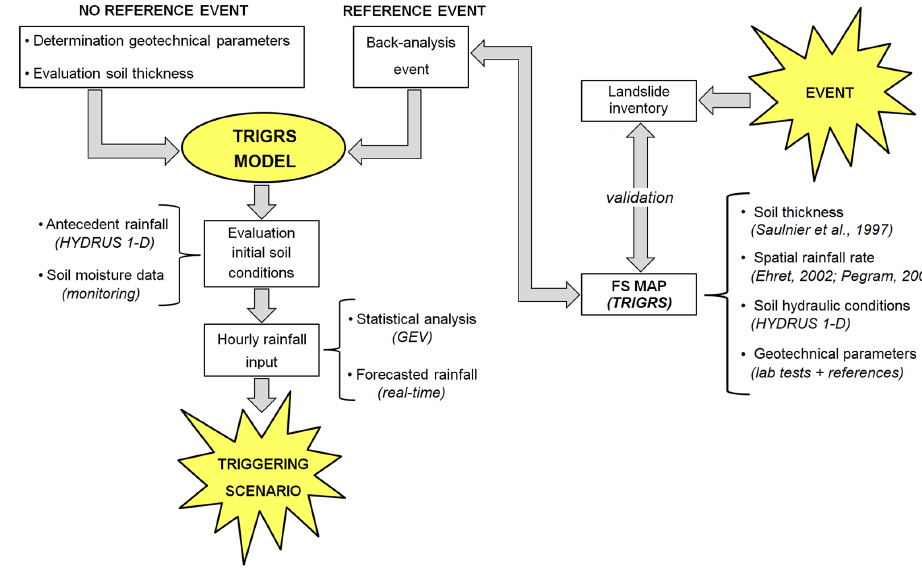
Figure 14. Flux diagram describing the proposed approach for the evaluation of shallow landslide-triggering scenarios. Table 8. Number of unstable pixels predicted by TRIGRS at the end of the simulated rainfall scenario T (0) and in the next 2h T (1h) and T (2h). P 2009 represents the percentage of the maximum number of predicted unstable pixels compared to those obtained in the back analysis of the 1 October 2009